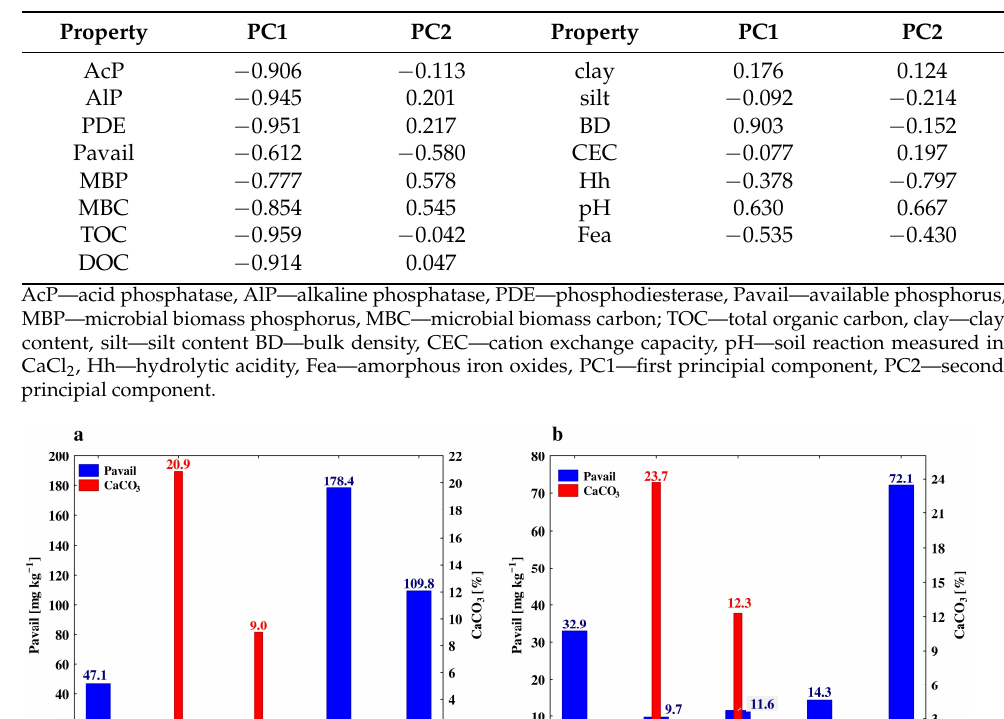
Figure 7. PCA analysis obtained from the studied soil variables: ( a ) plot of the PC1 and PC2 for the determined soil properties: Pavail—available phosphorus content, AcP—acid phosphatase activity,